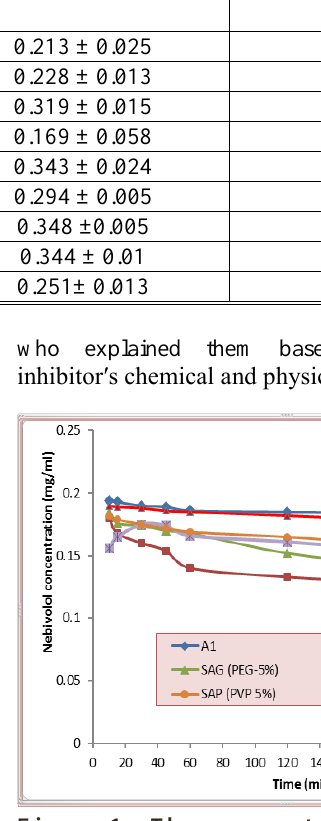
Figure 1. The apparent concentration-time profile of nebivolol-loaded conventional and polymer-based supersaturable SNE formulations in 0.1N